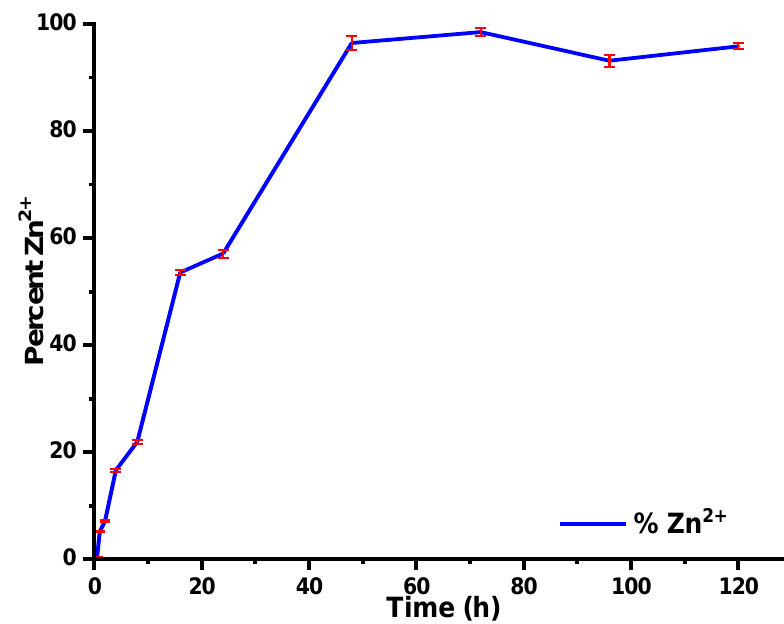
Figure 13. Percent Zn 2+ ions diffusing from the hydrogels per unit time (h).